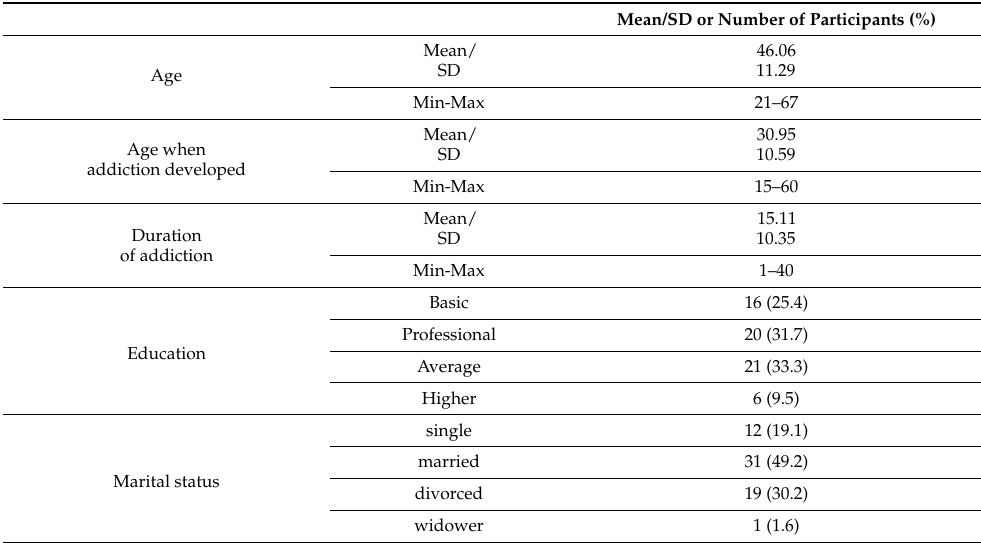
Table 1. Demographic characteristics of the study